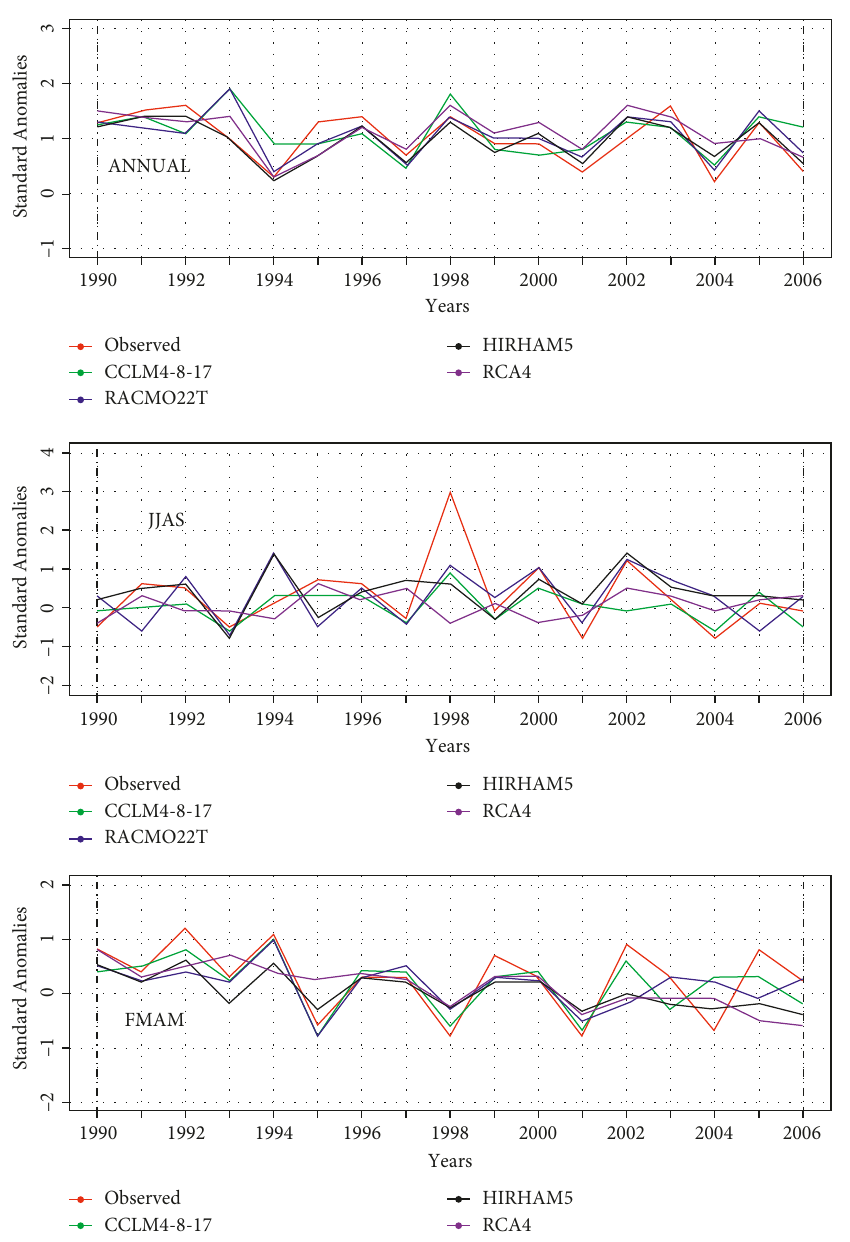
Figure 11: Interannual variability of standardized rainfall anomalies during summer (JJAS) and spring (FMAM) seasons of moderate rainfall. Table 11: Correlation coefficient for precipitation, maximum, and minimum temperatures of four RCMs. Climate variables